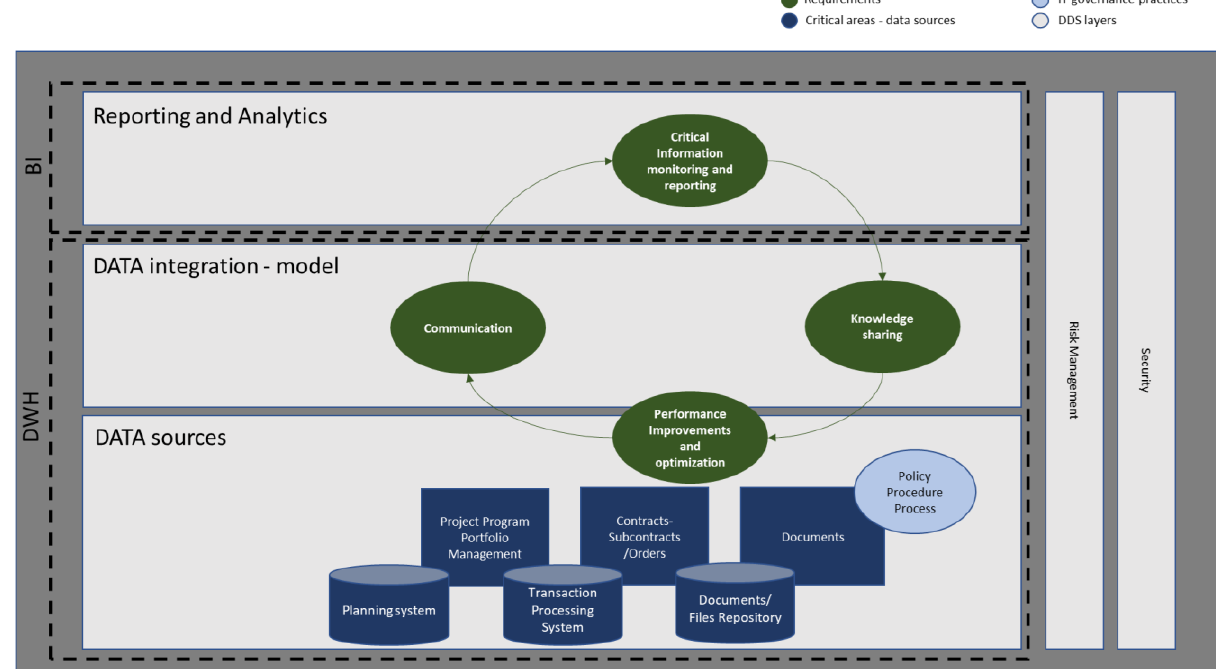
Figure 3. Data-driven governance framework for a performance monitoring domain. In grey are represented the DSS layers and in blue are the main data sources. The requirements in green have been mapped on the DSS layers.